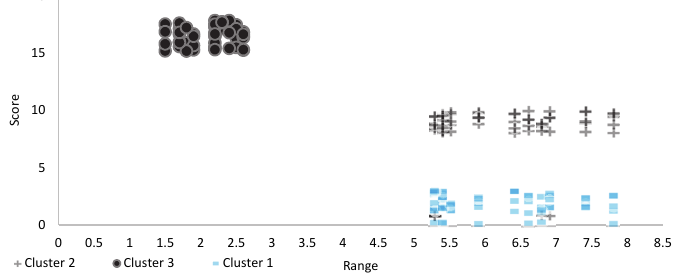
Fig. 1. Graphical view of cluster